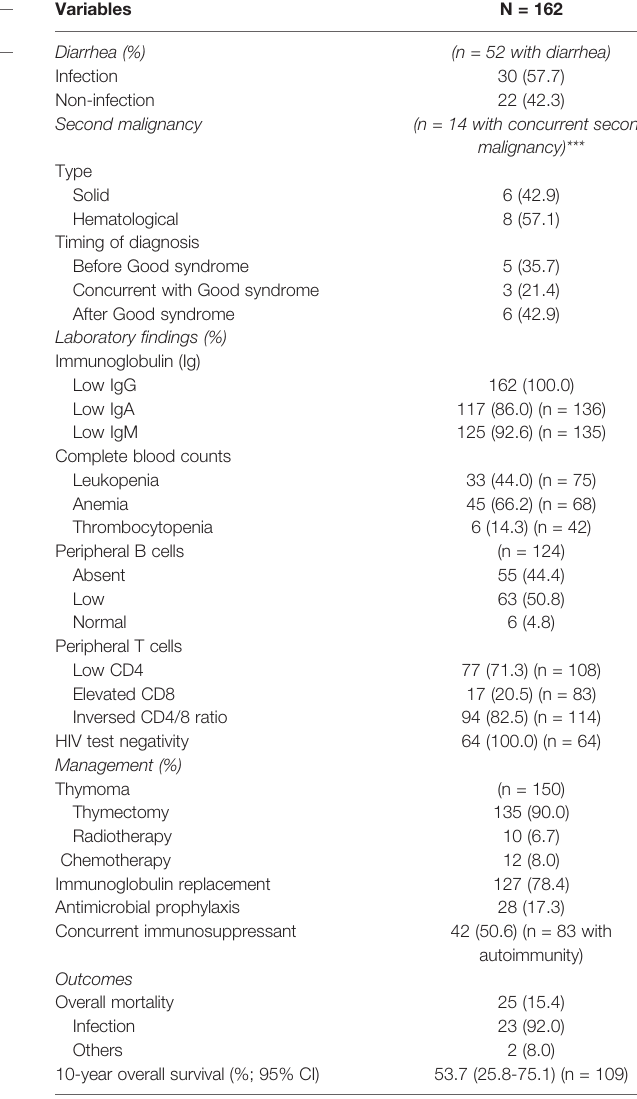
TABLE 1 | Clinical characteristics, management, and outcomes of patients with Good